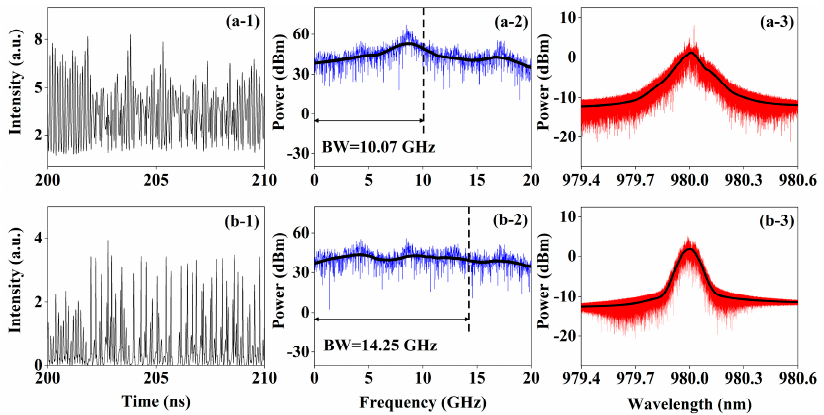
Figure 3. The time series, frequency spectra, and optical spectra for ( a-1 − a-3 ) XP mode and ( b-1 – b-3 ) YP mode of the free-running VCSEL1 when the bias current is 5.